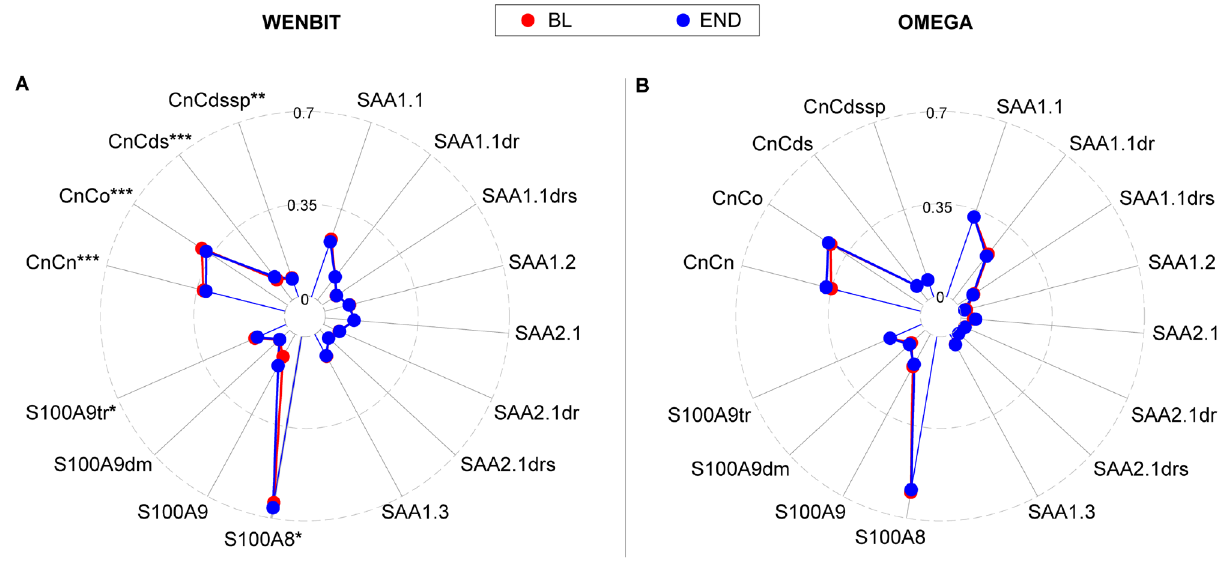
Figure 4. Comparison of proteoform distributions in WENBIT ( A ) and OMEGA ( B ). Values are geometric mean of relative proteoform concentrations, i.e. fraction of the total concentration of the actual biomarker. Distributions of SAA, S100A8/9 and CnC proteoform levels were highly stable over time in both groups. Small significant differences were observed for CnC and S100A8/9 in WENBIT. BL Baseline, END End of follow-up. *, p < 0.05; **, p < 0.01; ***, p <